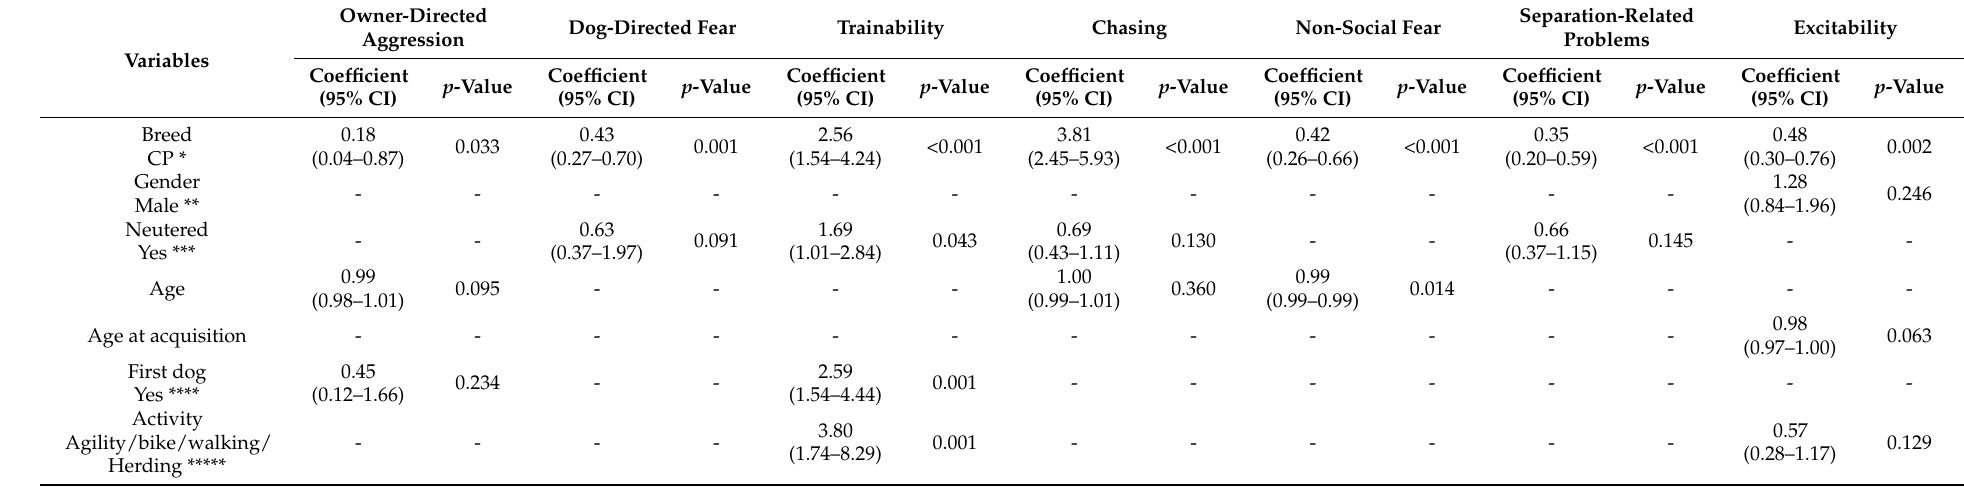
Table 4. Results of an ordinal regression model for the effect of the breed (Can de Palleiro [CP] breed versus the general population [GP] of dogs) on behavioural traits, as measured by the Canine Behavioural Assessment and Research